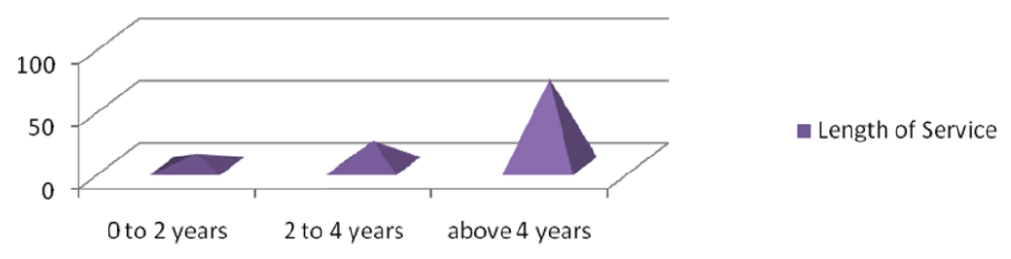
Figure 3: Length of service